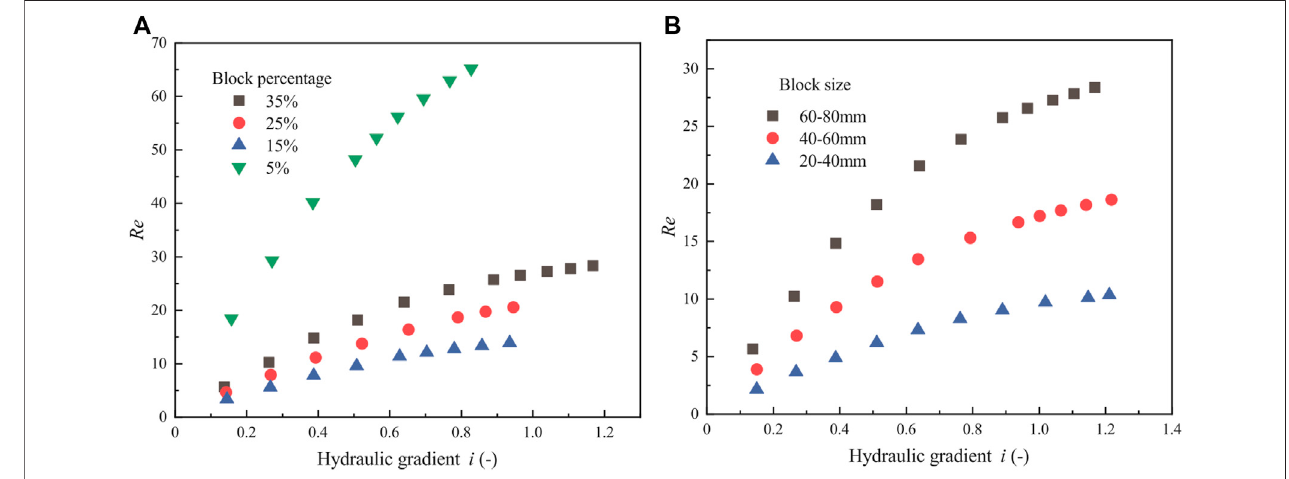
FIGURE 8 | Relationship between hydraulic gradient and Reynolds number for phyllite bimrock specimens with different block percentages and block sizes considering the orientation of blocks. (A) Group G1 test; (B) Group G2 test.